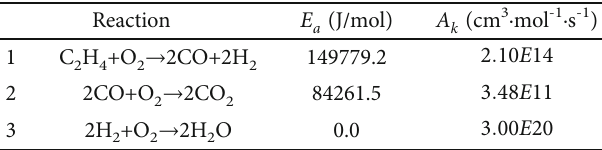
Table 1: Chemistry model of